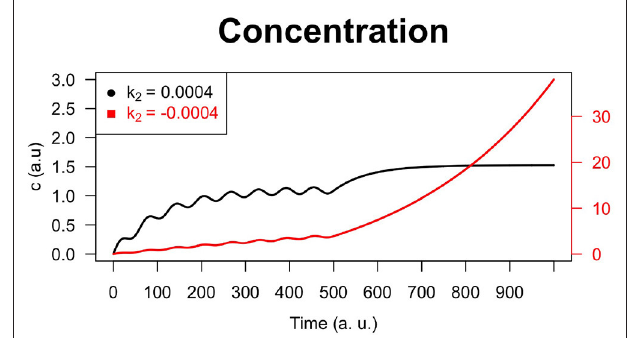
FIGURE 5 | Numerical simulation of the system defined by Equations (15) and (16) with E 0 = 0, E max = 100, k 1 = 0.005, k 2 = − 0.0004, EC 50 = 15, h = 0.001, k = 1, A = 0.001, B = 0.001. A negative value of k 2 causes the concentration curve to assume an increasing monotone trend, while a positive value of k 2 causes the curve to reach a plateau after an initial oscillatory